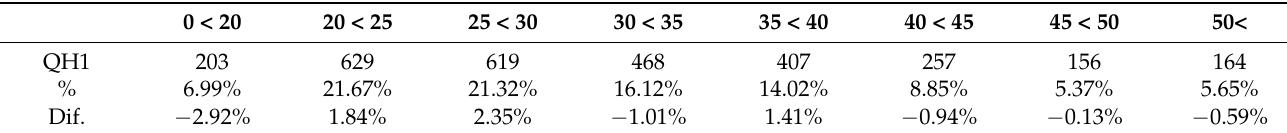
Table 8. Age difference and days of playing